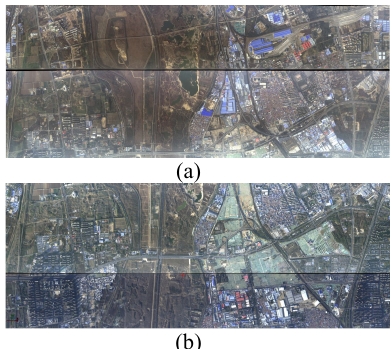
Figure 3. ADS 80 image strips for study area of 2016 and 2017 (a) ADS 80 image strips of 2016, (b) ADS 80 images strips of 2017 The most important advantage of SGM point cloud extraction is that the matched DSM data are irregular, non-smooth and no interpolation. Point clouds are more uniform and sparse in flat areas and increased appropriately in areas with mountainous area, which has a great effect on DTM generation by DSM filtering (Xu, 2019). The Dense DSM was generated based on nadir and backward viewing images of ADS80 data with SGM algorithm and the Census Transform (CT) was selected as matching cost value without considering setting the initial parallax value. Final DSM raster was interpolated with the resolution of 0.2 m. DSM of 2017 is shown in Figure 4 (a) and the local result of red range of Figure 4 (a) is shown in Figure 4 (b).